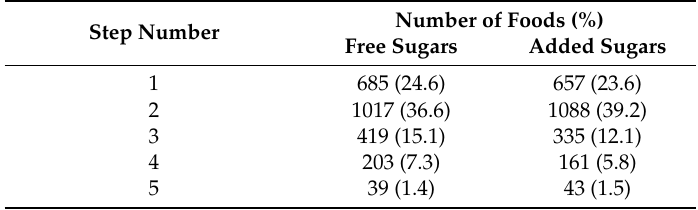
Table 1. Step allocation for free and added sugar